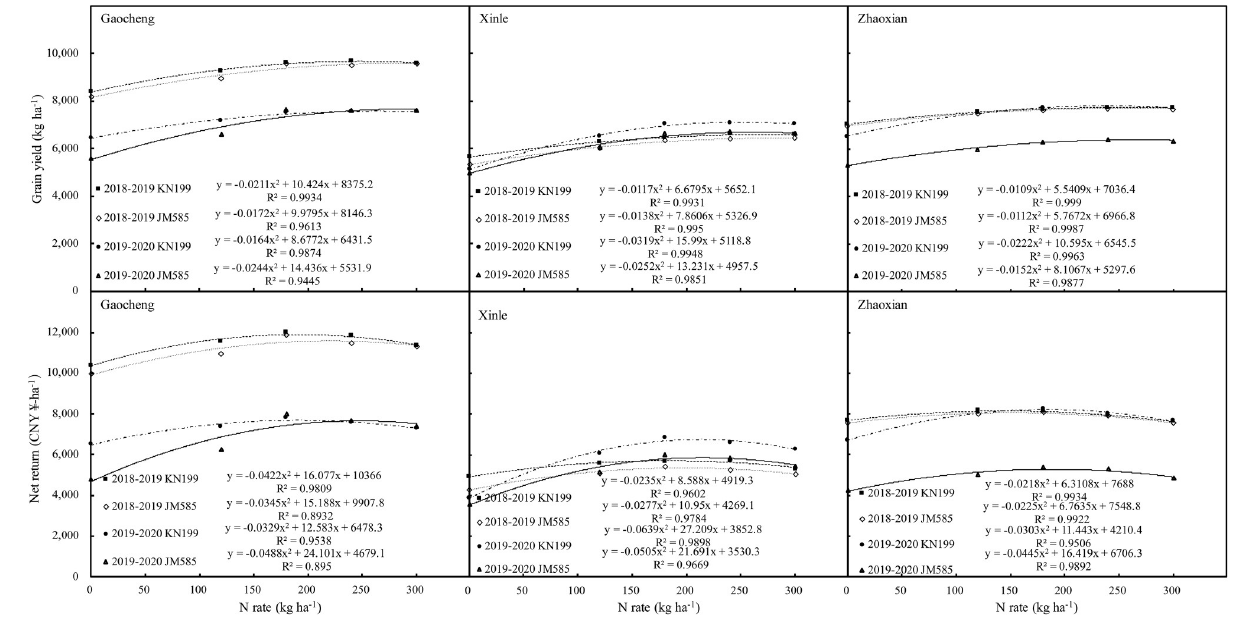
Fig 6. Correlation of winter wheat grain yield and economic return to nitrogen fertilization